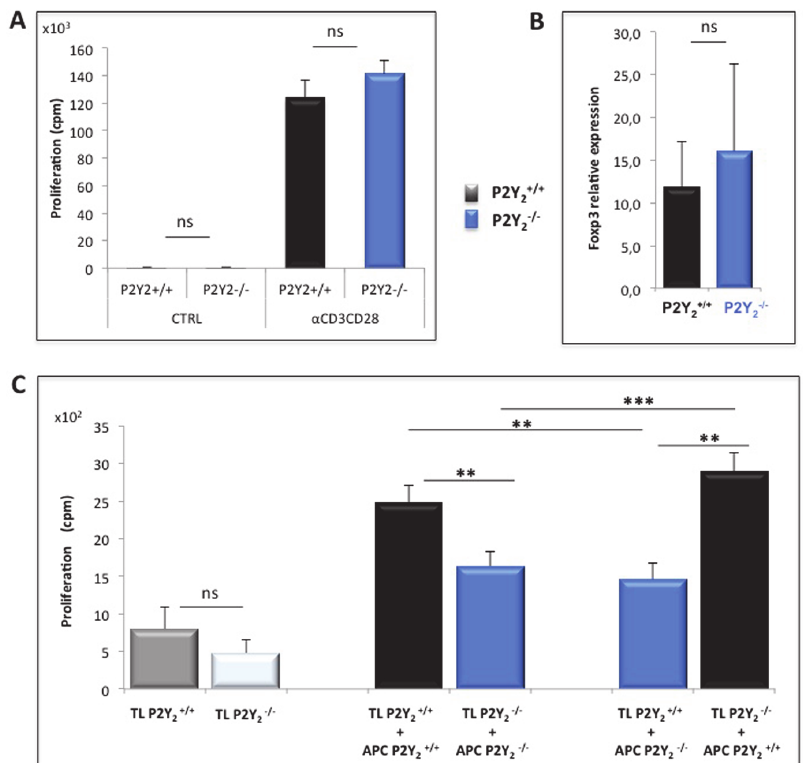
Fig 6. P2Y 2-/- reduced TL proliferation in response to in vitro IRBP restimulation is linked to a defect in P2Y 2-/- APC activation capacities. Twelve days after s.c. immunization with IRBP 1 – 20 peptide, P2Y 2+/+ and P2Y 2-/- mice were sacrificed and their spleen and draining lymph nodes collected and dissociated. (A) Splenic TL were semi-purified by passage on nylon wool fiber columns and pooled with LN cells before being in vitro restimulated in medium alone (CTRL) or supplemented with Dynabeads Mouse T-activator CD3/ CD28. TL proliferation was tested after 72h by ( 3 H)-thymidine incorporation. Data are from a representative experiment of 6 with 4 mice per group. ns: not significant (B) Spleens from P2Y 2+/+ and P2Y 2-/- IRBP- immunized were independently processed and analyzed by qPCR for β -Actin, CD3 and Foxp3 mRNA expression. Data are from 5 different mice in each group and are expressed as relative expression of Foxp3 versus CD3. ns: not significant (C) CD4+ TL were isolated from LN of P2Y 2+/+ and P2Y 2-/- mice by magnetic separation and co-cultured with total irradiated (30 Gy) splenocytes (APC) in autologous and cross-culture conditions, in presence of IRBP 1 – 20 peptide. TL proliferation was tested after 72h by ( 3 H)-thymidine incorporation. Data, expressed in cpm, are from a representative experiment of 3 with 4 mice per group. ns: not significant; ** p < 0,01; *** p <